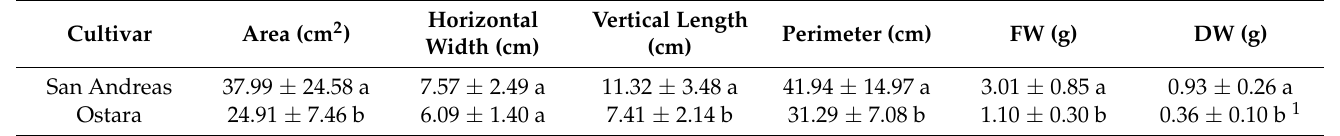
Table 1. Biometrical characteristic of leaves of two strawberry cultivars.